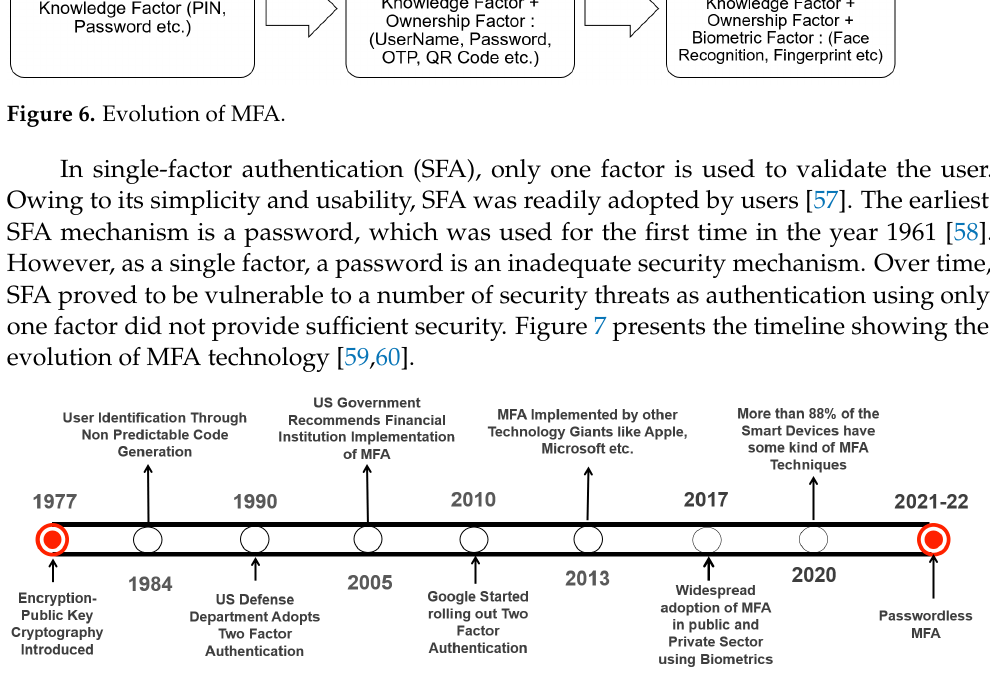
Figure 7. Key events in the evolution and adoption of MFA security mechanism.